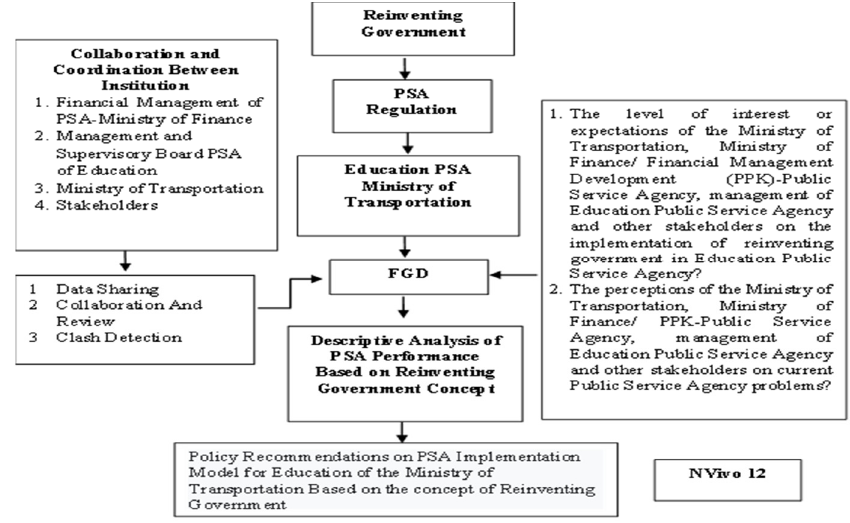
Figure 1. Framework. Figure 1.